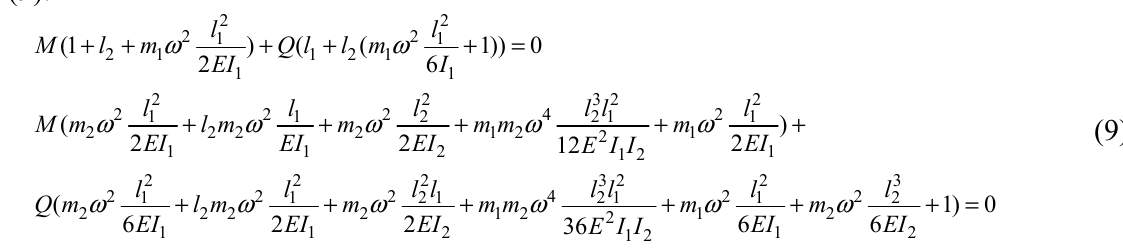
Figure 5. The relationship between frequency and various dimensions, ( a ) The length; ( b ) The width, and ( c ) The ratio of the l